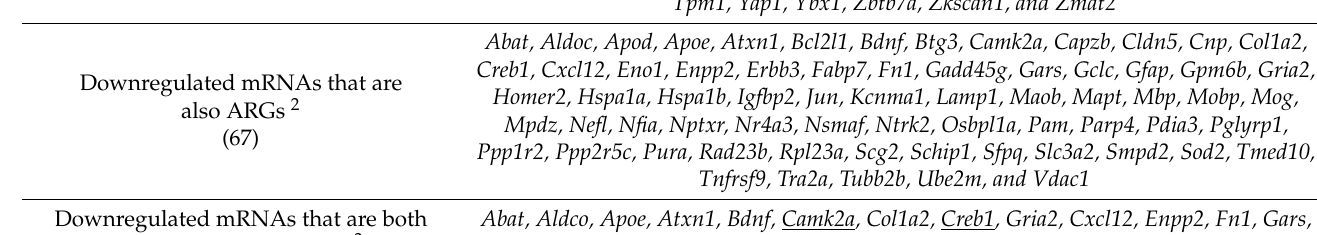
Downregulated mRNAs that are upregulated in HuD OE mice and HuD targets 1